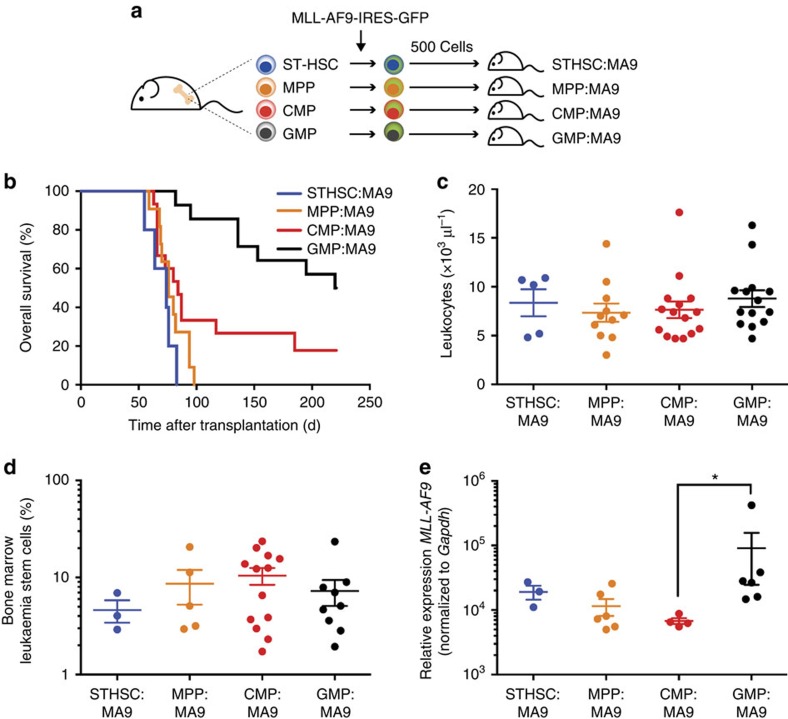
Cell of origin alters tumour aggressiveness of in vivo-derived AML.(a) Schematic diagram of experimental design to test in vivo transformation of distinct cells of origin by MA9. (b) Overall survival of mice transplanted with 500 MA9-transduced cells from distinct cells of origin (STHSC:MA9; n=5, MPP:MA9; n=11, CMP:MA9; n=15, GMP:MA9; n=14). Data were collected over three biological replicate experiments. Log-rank test; P=0.0004. (c) Peripheral blood leukocyte count in terminal mice transplanted with MA9-transduced cells (STHSC:MA9; n=5, MPP:MA9; n=11, CMP:MA9; n=15, GMP:MA9; n=14). Data were collected over three biological replicate experiments. Centre bars indicate mean. Error bars indicate s.e.m. Kruskal-Wallis test; P=0.5622. (d) Average frequency of LSCs (L-GMP20) in the bone marrow of terminal mice (STHSC:MA9; n=3, MPP:MA9; n=6, CMP:MA9; n=13, GMP:MA9; n=9). Data were collected over three biological replicate experiments. Centre bars indicate mean. Error bars indicate s.e.m. Kruskal–Wallis test; P=0.7031. (e) Relative expression of MA9 assessed by real-time PCR in splenic leukaemia cells in terminal mice (STHSC:MA9; n=3, MPP:MA9; n=6, CMP:MA9; n=4, GMP:MA9; n=6). Data were collected over three biological replicate experiments. Centre bars indicate mean. Error bars indicate s.e.m. Kruskal–Wallis test; P=0.0055. Dunn's multiple comparisons test; *P<0.05.